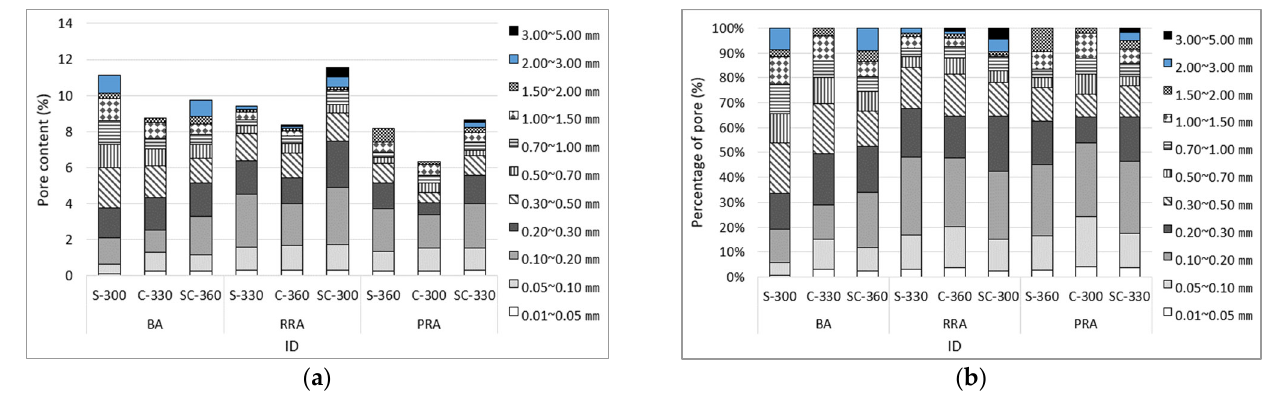
Figure 15. Pore content and percentage in concrete mixture. ( a ) Pore content in concrete; ( b ) per ‐ centage of pore distribution in concrete.